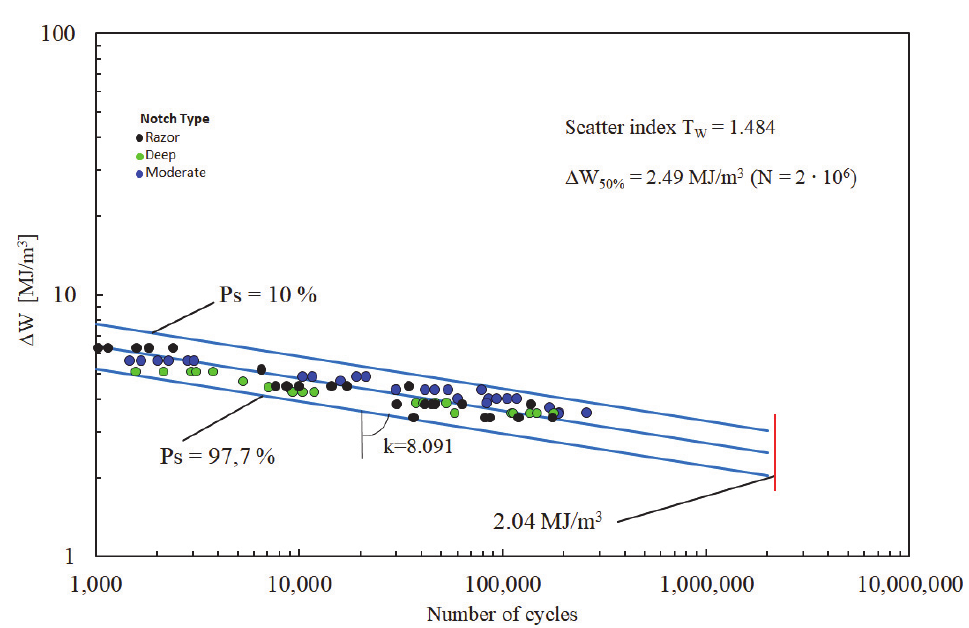
Figure 7: Synthesis of PEEK fatigue data by means of SED